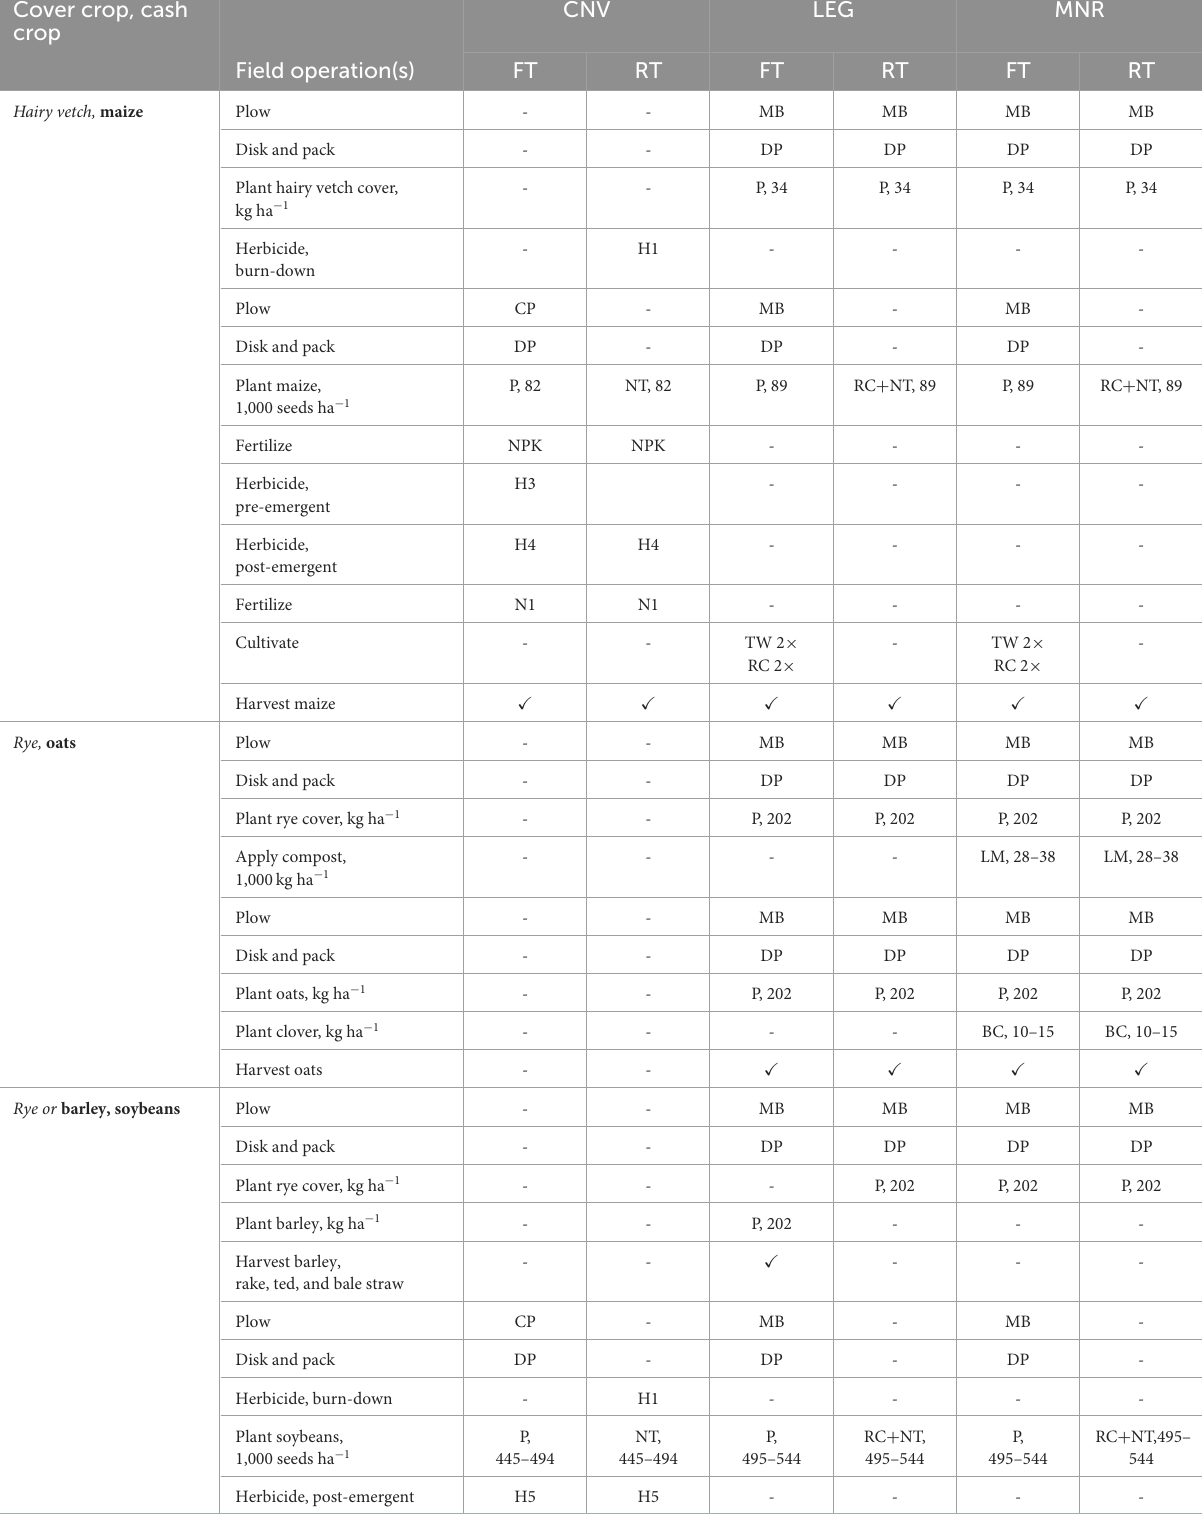
TABLE 1 Typical field operations for each crop grown in each treatment. Cover crop, cash